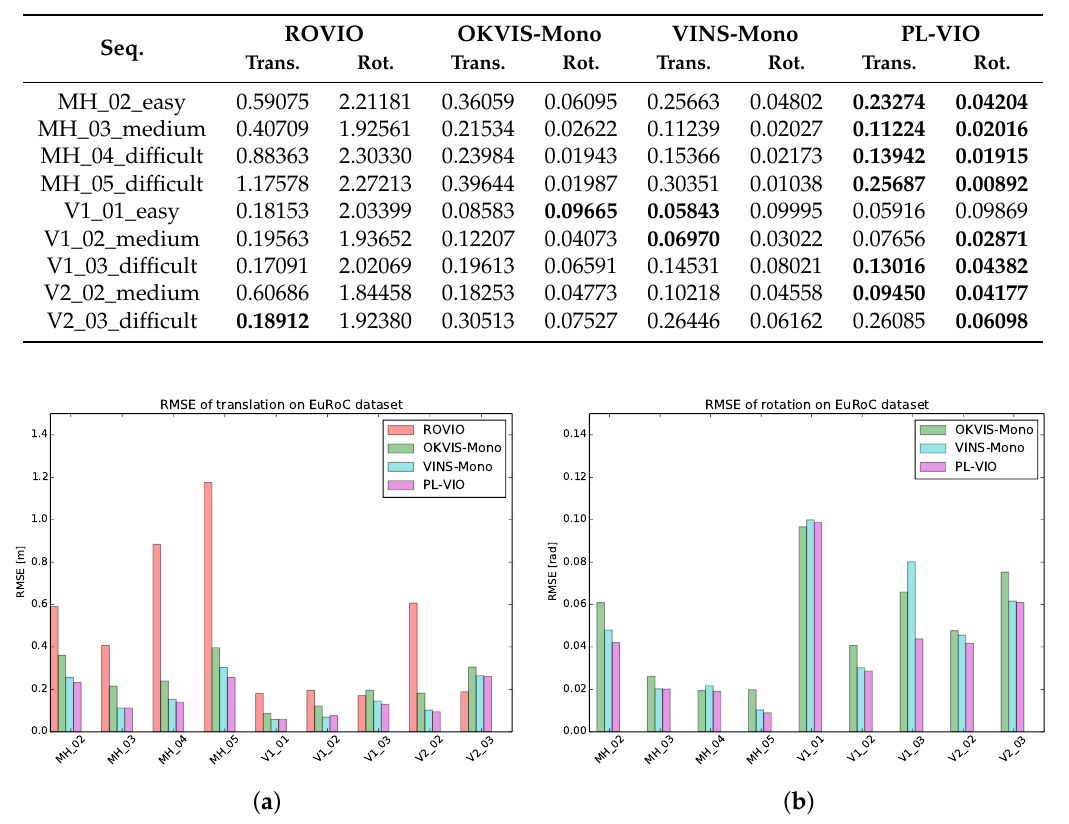
Table 1. The root mean square error (RMSE) results on the several EuRoc MAV dataset. The translation (m) and rotation (rad) error are listed as follows. The numbers in bold represent the estimated trajectory is more close to the benchmark trajectory.